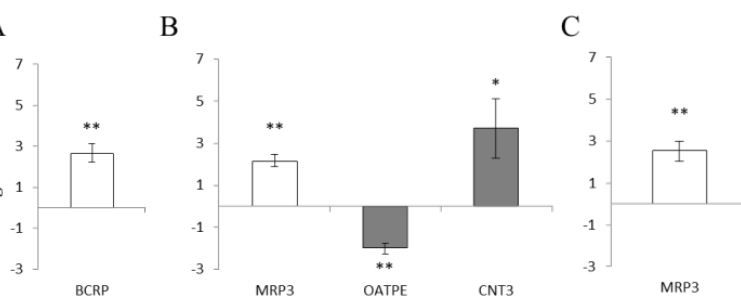
Figure 7. Modulation of drug transporter mRNA expression in cells stimulated with female sex hormones. ( A ) HEC-1A cells stimulated with 100 nM β -estradiol ( B ) VK2/E6E7 cells stimulated with 100 nM β -estradiol ( C ) VK2/E6E7 cells stimulated with 750 nM progesterone for 72 h. The SYBRgreen ® chemistry was used. White bars represent ABC transporters. Grey bars represent SLC transporters. Data is presented as fold-change versus 0.01% ethanol control ± SD ( n = 3). Statistical analysis was a two-tailed students t -test * p < 0.05, ** p < 0.005.